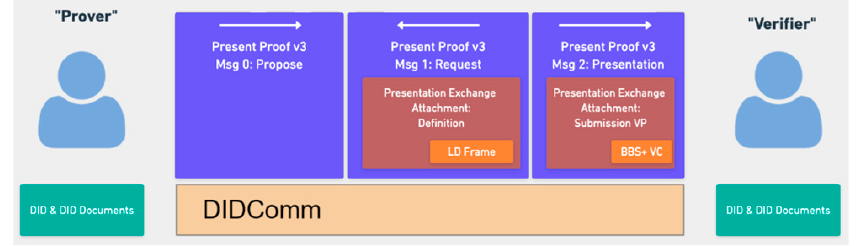
Figure 3. The components of WACI presentation exchange [21].